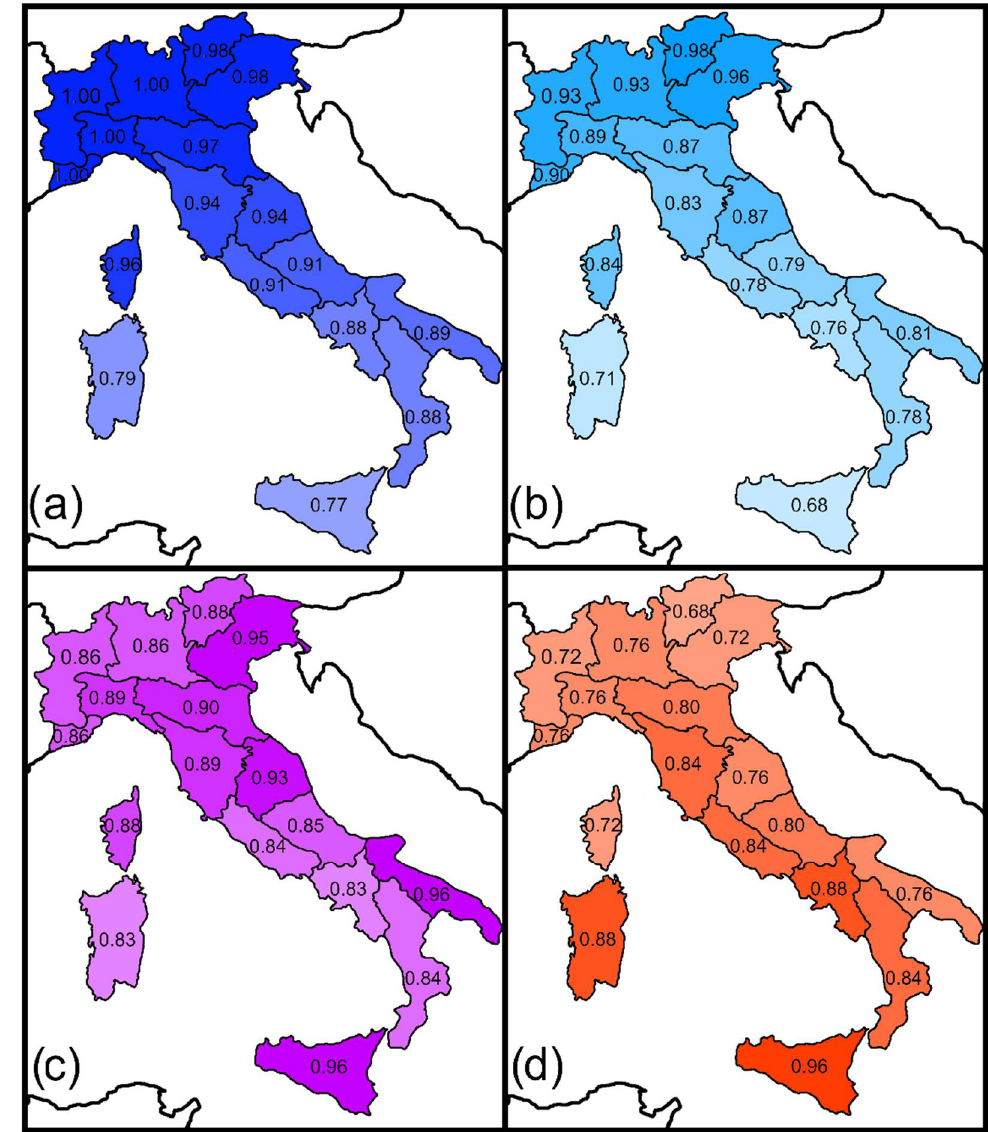
Figure 4. Spatial variations in the Simpson index between Italian regions and adjacent major areas for odonates (total number of species): ( a ) Western Europe; ( b ) Central Europe; ( c ) Eastern Europe; ( d ) Northern Africa. Results for Zygoptera and Anisoptera are shown in Figures S2 and S4, respec- tively. Table 3. Correlation between biogeographical similarity (the Sørensen and Simpson indices) and latitude for species living also in Western Europe, Central Europe, Eastern Europe, and Northern Africa. Sørensen Index Simpson Index